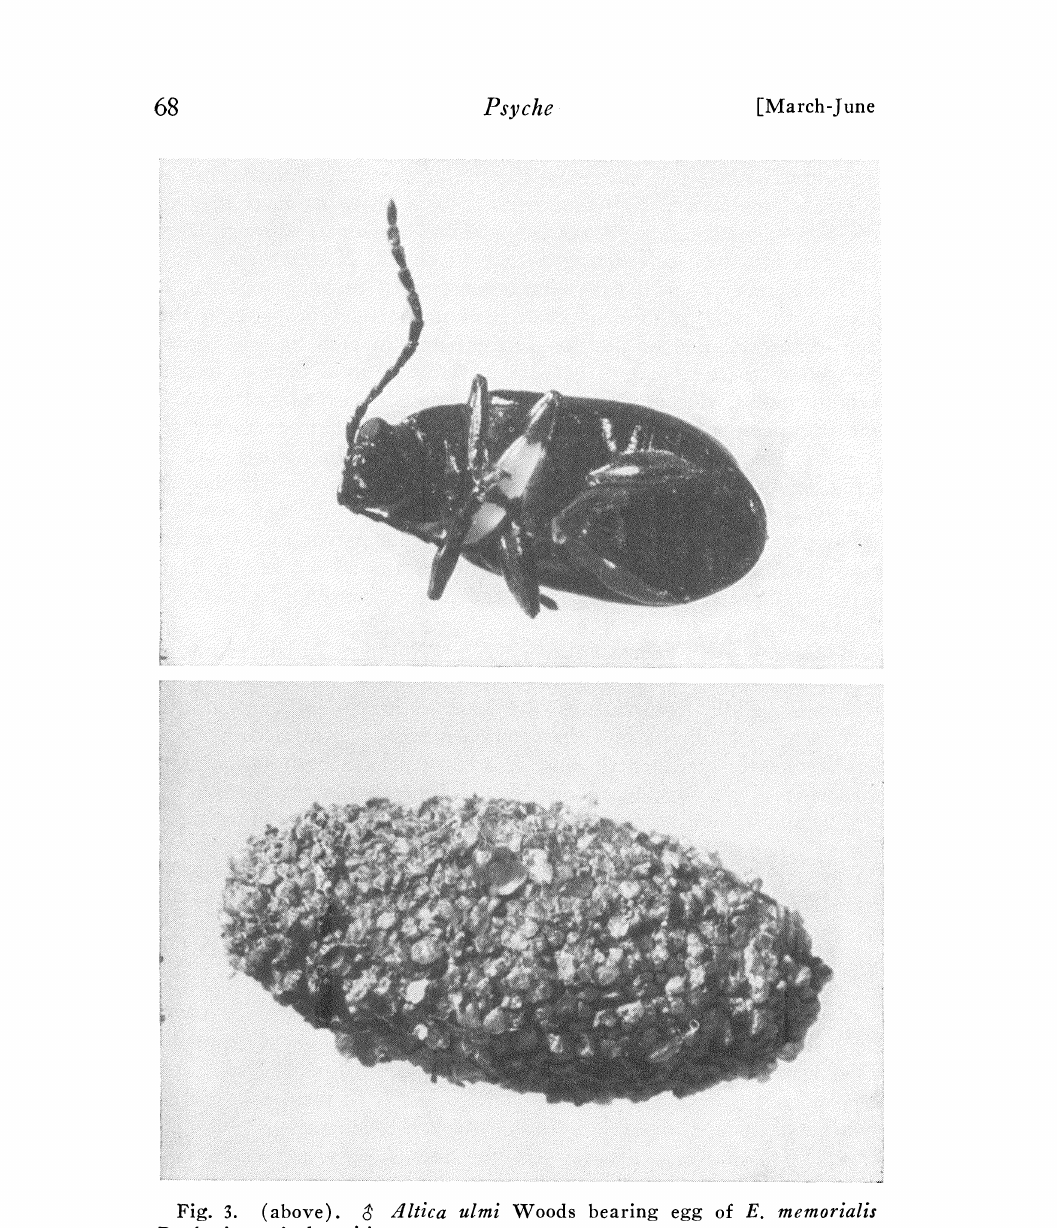
Fig. 3. (above). $ Altica ulmi Woods bearing egg of E. memorialis Banks in typical position. Fig. 4. (below). Cocoon of E. memorialis